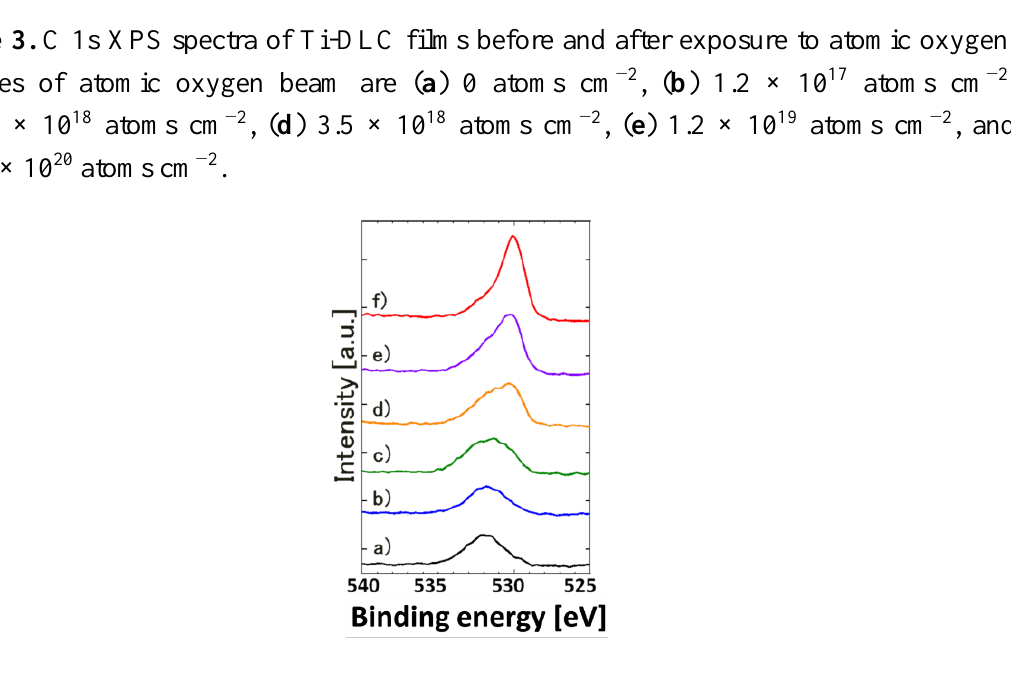
Figure 4. O 1s XPS spectra of Ti-DLC films before and after exposure to atomic oxygen. Fluences of atomic oxygen beam are ( a ) 0 atoms cm −2 , ( b ) 1.2 × 10 17 atoms cm −2 , ( c ) 1.2 × 10 18 atoms cm −2 , ( d ) 3.5 × 10 18 atoms cm −2 , ( e ) 1.2 × 10 19 atoms cm −2 , and ( f ) 1.9 × 10 20 atoms cm −2